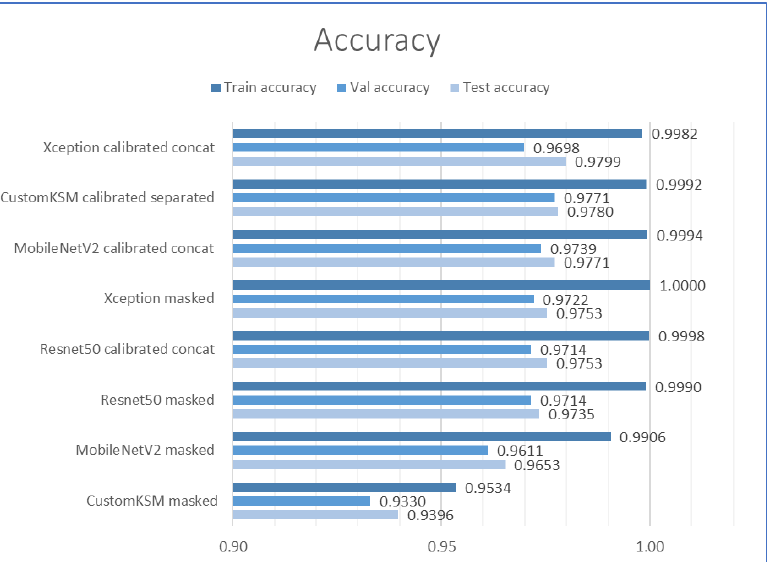
Figure 10. Accuracy of the tested models for train, val and test datasets, the higher the